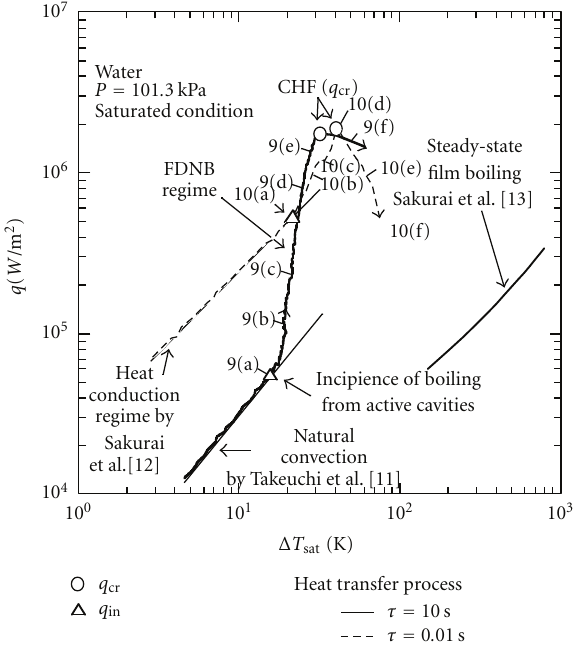
Figure 8: Heat transfer process for period τ = 10s and 0.01 s at atmospheric pressure in saturated water. Photographs shown in Figures 9 and 10 were taken at points of Figures 9(a) to 9(f) and Figures 10(a) to 10(f) on the graph, respectively.